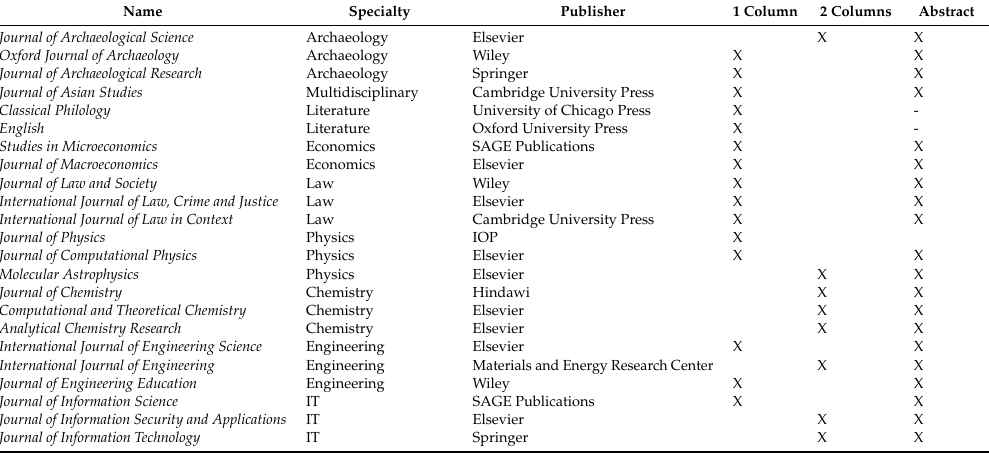
Table A1. List of randomly sampled journals from di ff erent fields. Their current layout and the presence of abstracts are